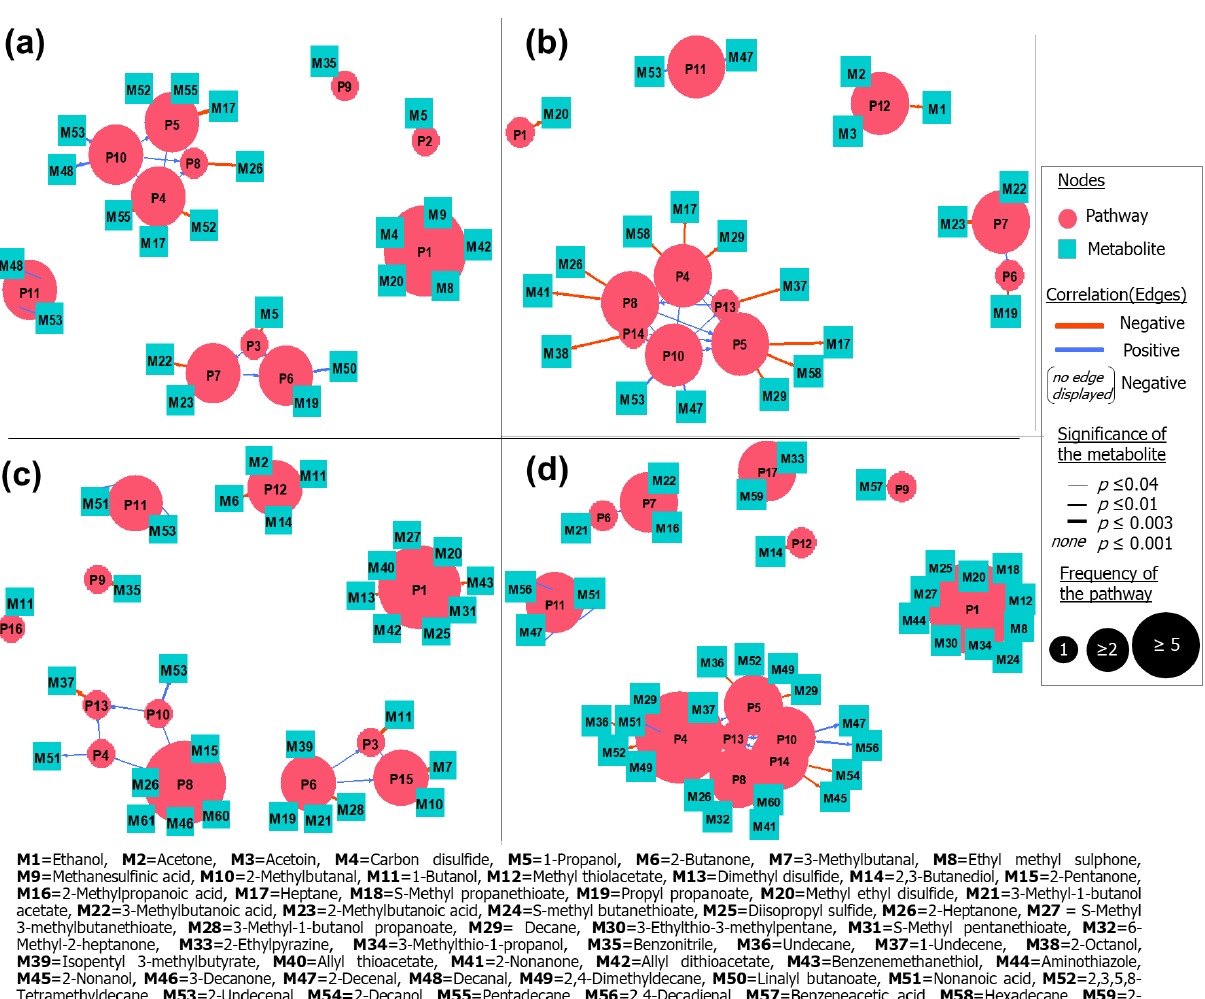
Figure 8. Pathway network analysis presenting the relations between most relevant metabolites (squares) and likely associated bacterial processes (circles) for ( a ) E. coli , ( b ) E. faecalis , ( c ) K. pneumoniae and ( d ) P. mirabilis . P1 = metabolism of S-containing amino acids, P2 = propanoate metabolism, P3 = Ehrlich pathway—reduction of keto acids, P4 = fatty acids